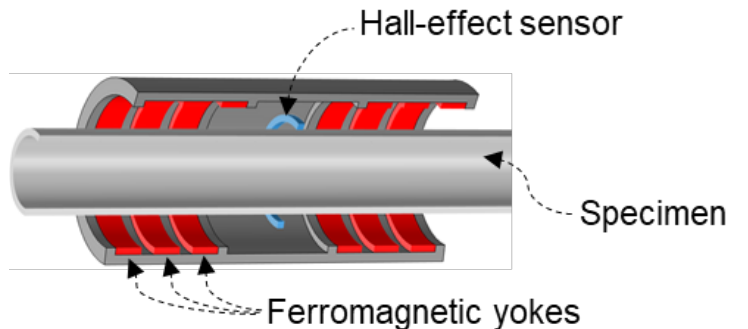
Figure 3. Schematic cut-section of the simulation model.